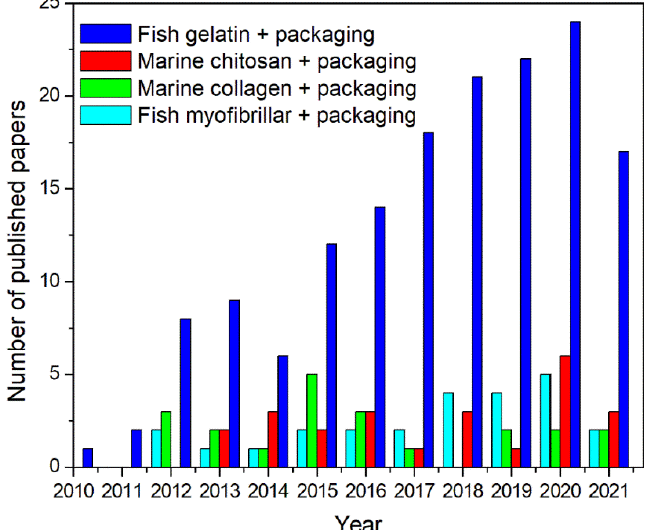
Figure 2. Distribution of scientific papers analyzed by the publication year in the last ten years up to June 2021 (from Scopus database).